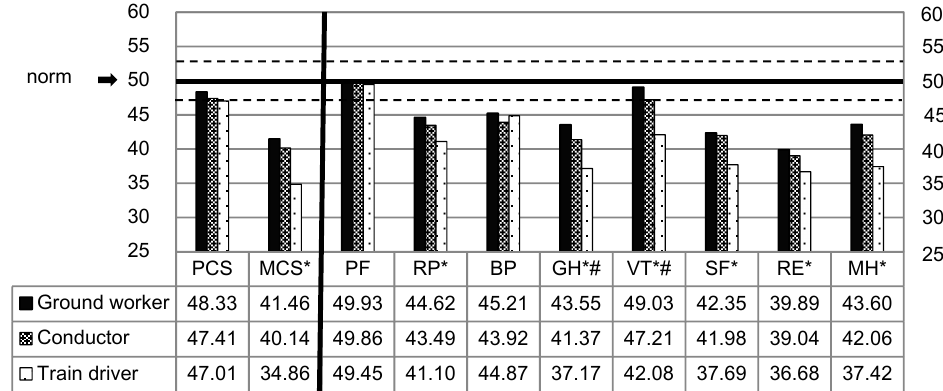
Figure 2. Mean norm-based scores of Short Form 36 version 2 (SF-36v2) health domains and component summary measures by group. Higher mean norm-based scores reflect better perceptions on the domains and summaries. The dashed lines indicate the upper (53) and lower (47) bounds of norm-based scores considered to be in the average range of functioning for group respondents; * statistical differences among three subgroups: ground workers and conductors both scored significantly higher than train drivers ( p < 0.05); # statistical differences between the scores of conductors and ground workers ( p < 0.05). BP: bodily pain; GH: general health; MCS: mental component summary; MH, mental health; PCS: physical component summary; PF: physical functioning; RE: role-emotional; RP: role-physical; SF: social functioning; VT, vitality.